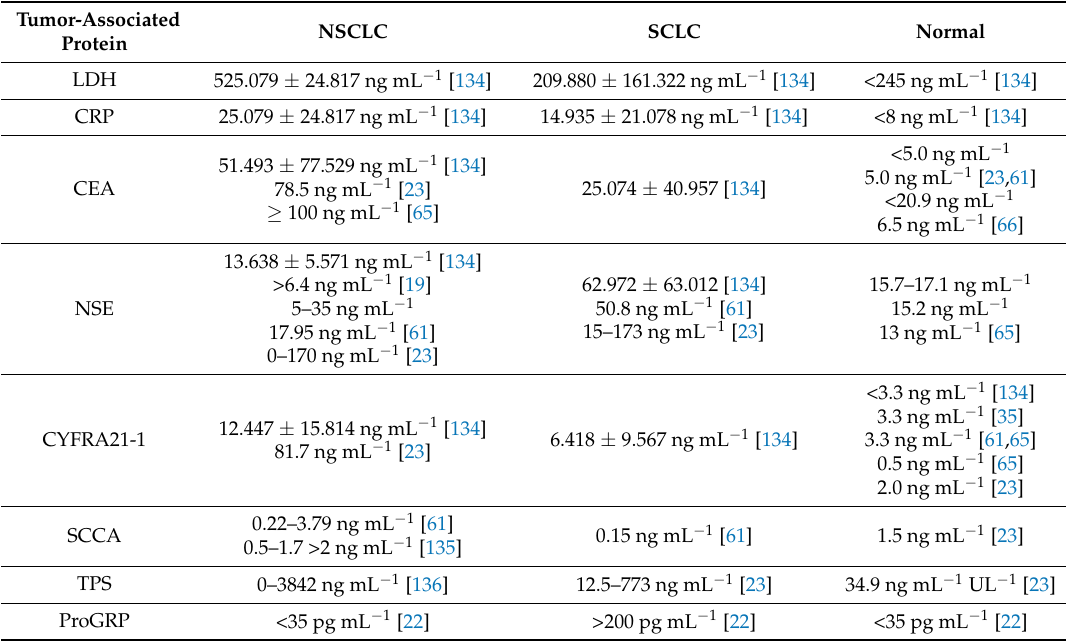
Table 4. Comparative levels of lung cancer biomarkers in blood plasma of patients with non-small-cell lung carcinoma (NSCLC) and small-cell lung carcinoma (SCLC) and healthy people. Tumor-Associated Protein